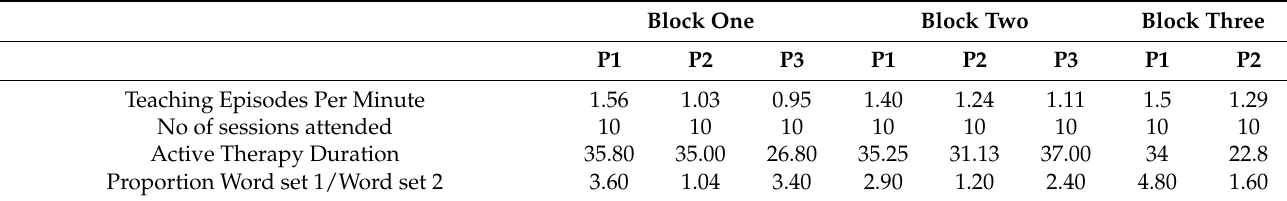
Table 4. Fidelity to Intervention